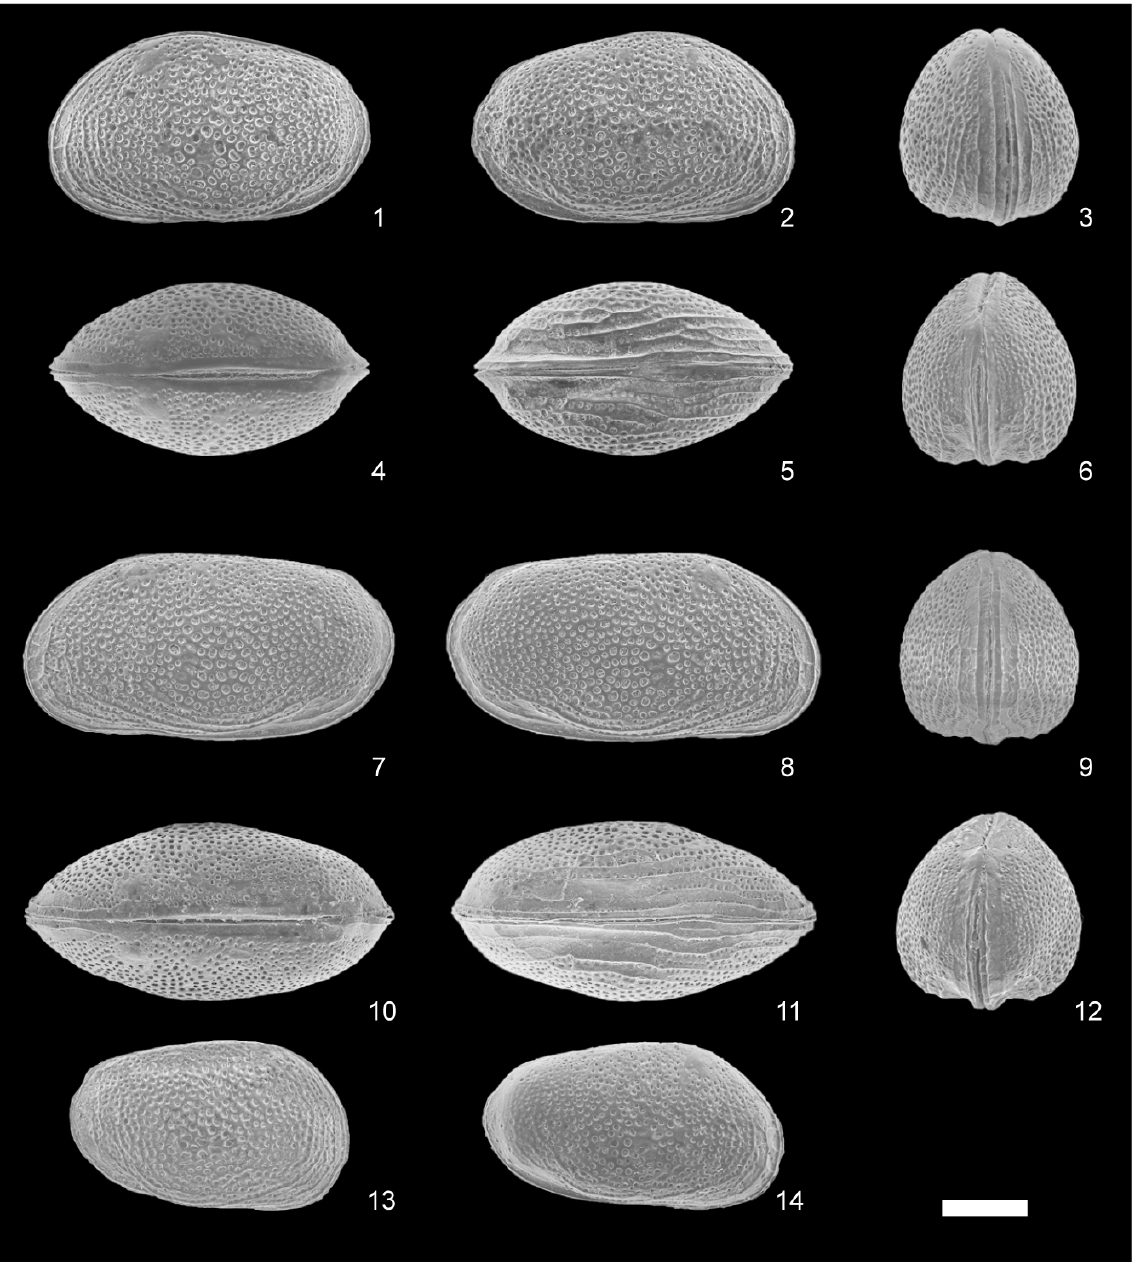
Figure 6. Scanning electron photomicrographs of the carapaces of Loxoconcha cotoensis sp. nov. female (VNMN.0099) (1–6); male (VNMN.0100) (7–12); female A-1 (VNMN.0101) (13) and male A-1 (VNMN.0102) (14) from the Co To Islands, northeastern Vietnam: (1, 7) left lateral view; (2, 8) right lateral view; (3, 9) anterior view; (4, 10) dorsal view; (5, 11) ventral view; (6, 12) posterior view. (13), right lateral view, male, A-1; (14), right lateral view, female, A-1. Scale bar is 100µm.